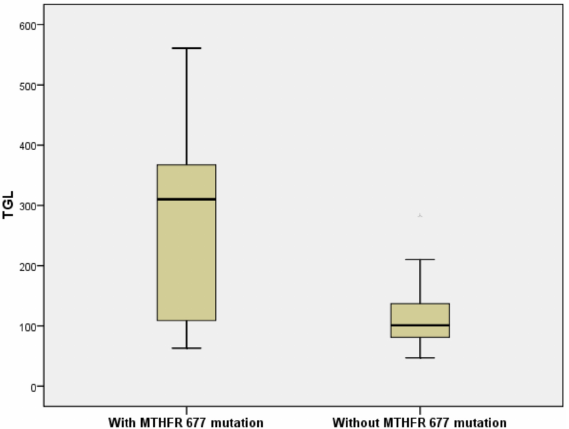
Figure 3. C677T mutation in the MTHFR gene is associated with a high risk for hypertrygliceridemia (OR = 1.392, 95%CI = (1.192,